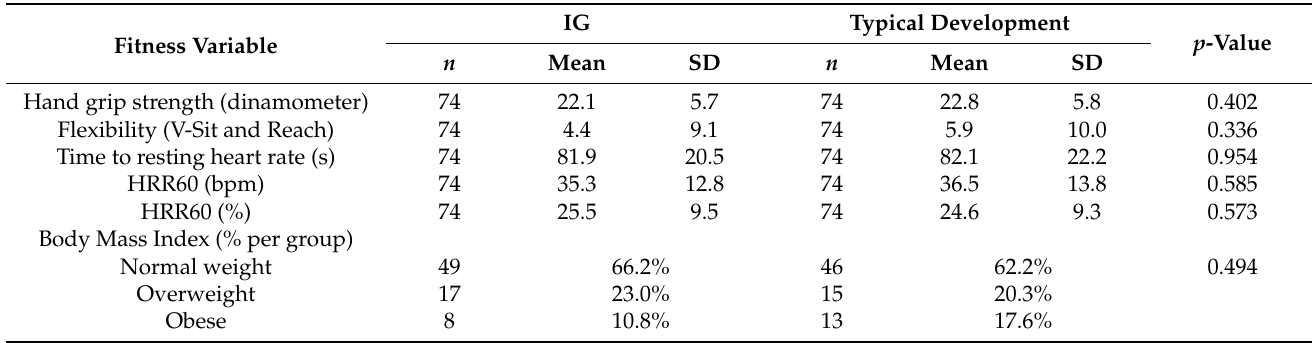
Table 2. Comparison of fitness measurements.